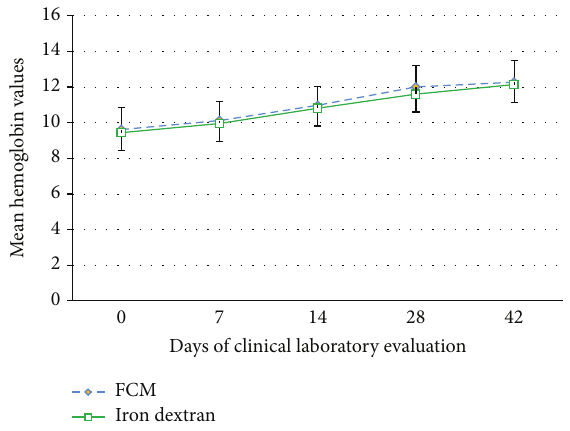
Figure 3: Mean hemoglobin values for FCM and DEX